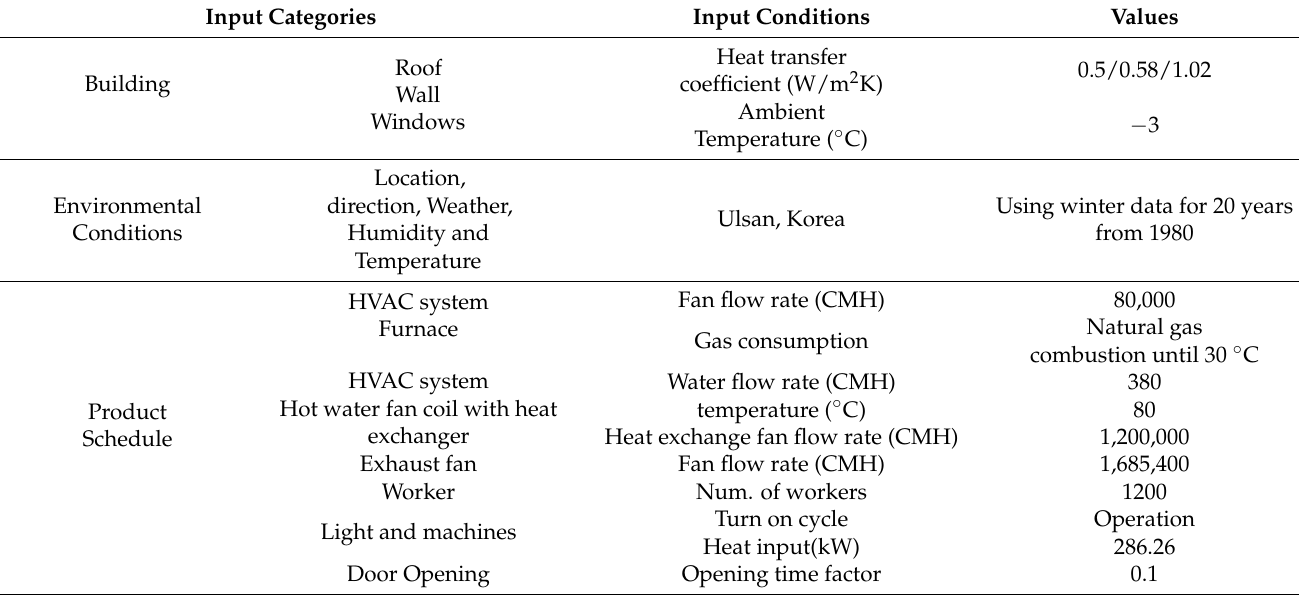
Table 4. Input conditions and values for building energy simulation